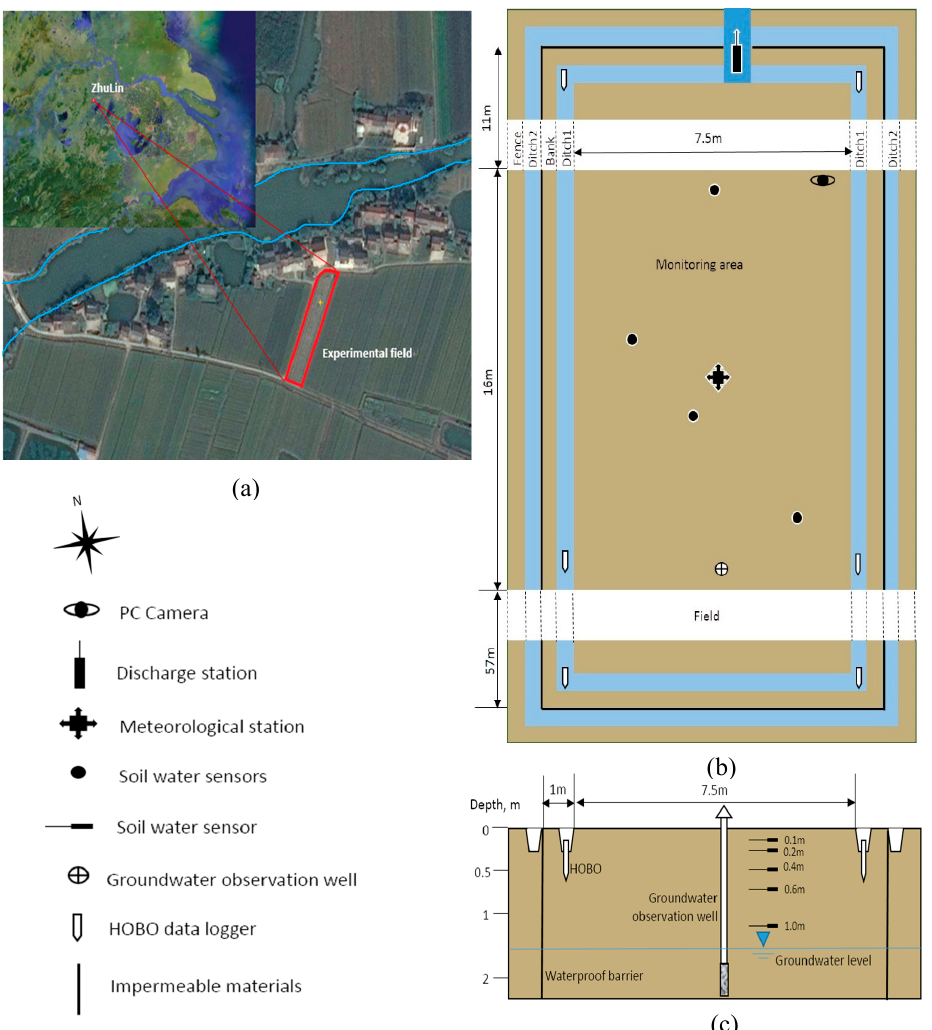
Figure 1. Field tests: ( a ) Site of the study in Taihu Basin; ( b ) layout of the experimental field; and ( c ) vertical layout of the field (0.0–2.0 m